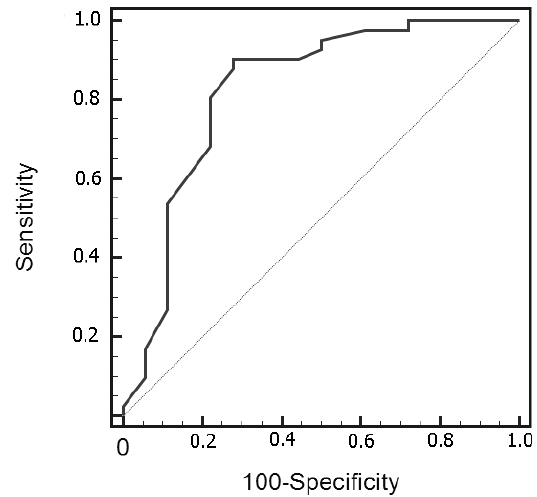
Figure 3. Receiver operating characteristic curve analysis in differentiating grade 1 from grade 2/3